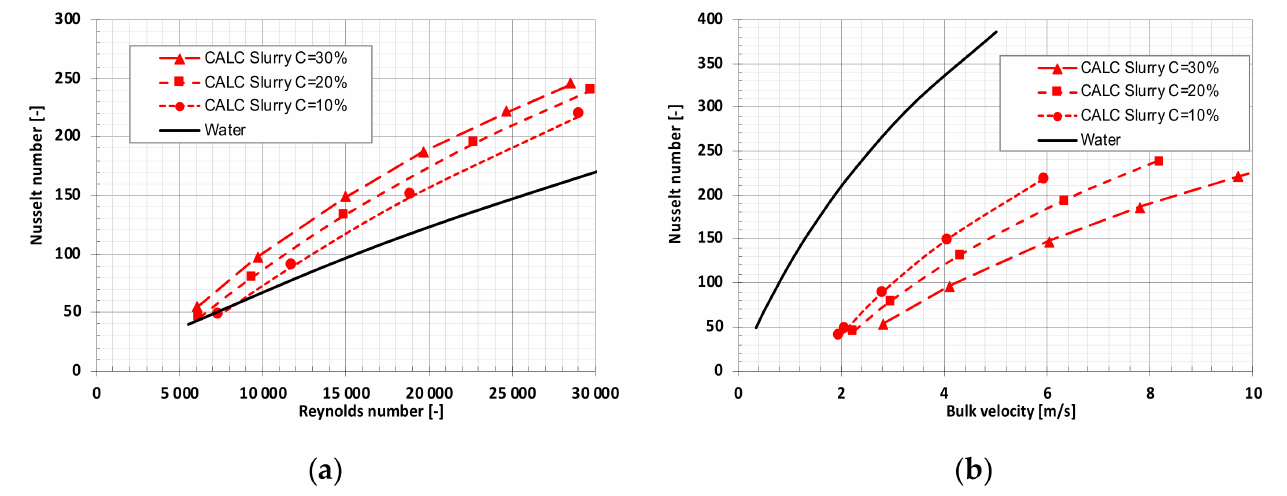
Figure 6. ( a ) Influence of Reynolds number on the Nusselt number for fine dispersive slurry and water; ( b ) Influence of bulk velocity on the Nusselt number for fine dispersive slurry and